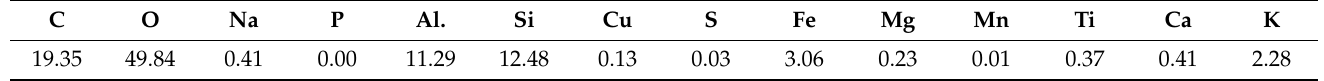
Table 2. Average elemental composition of the spherical nonmagnetic particle from Figure 5 (in